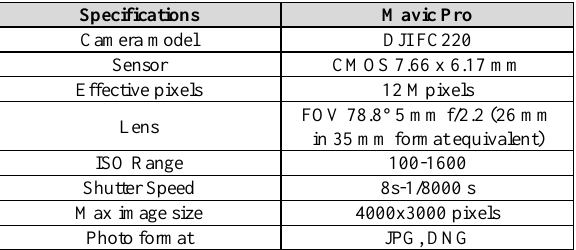
Table 1. DJI Mavic Pro principal